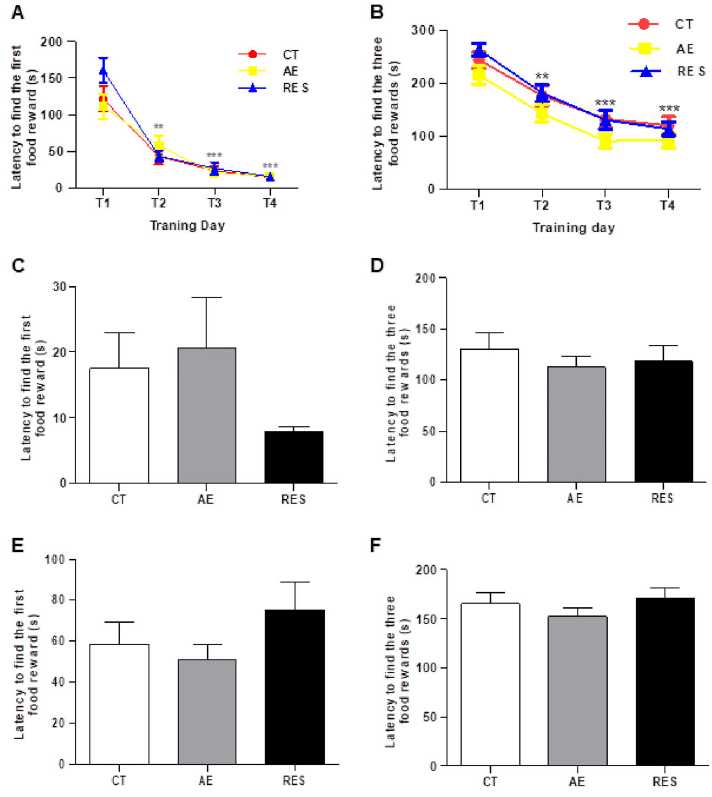
Figure 3. Assessment of cognitive function in the modi fi ed hole board test. The learning capacity was measured by the latency to fi nd the fi rst ( A ) and all three ( B ) food rewards during the four training days (T1-T4). **P o 0.01, ***P o 0.001 compared to day 1 (repeated- measures one-way ANOVA followed by Tukey ’ s post hoc ). Latencies were analyzed on the fi fth day in the location shift phase ( C and D ) and in the reversal phase ( E and F ) (one-way ANOVA). Data are reported as means ± SE (n=14 – 16 per group). CT: sedentary control; AE: aerobic exercise on the treadmill; RES: resistance exercise on the ladder